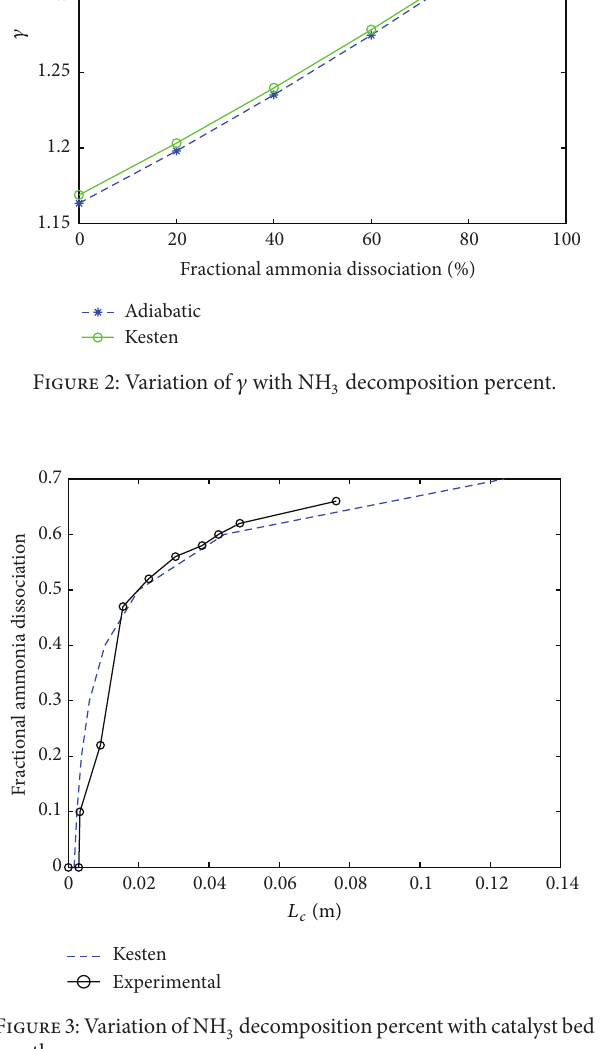
Figure 4: Input-output flow data of propellant tank subsystem